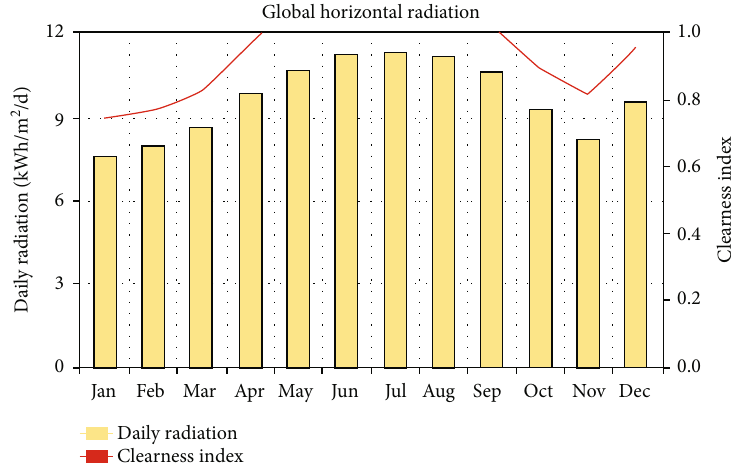
Figure 7: Solar radiation data of Nilgaon village in Haripur